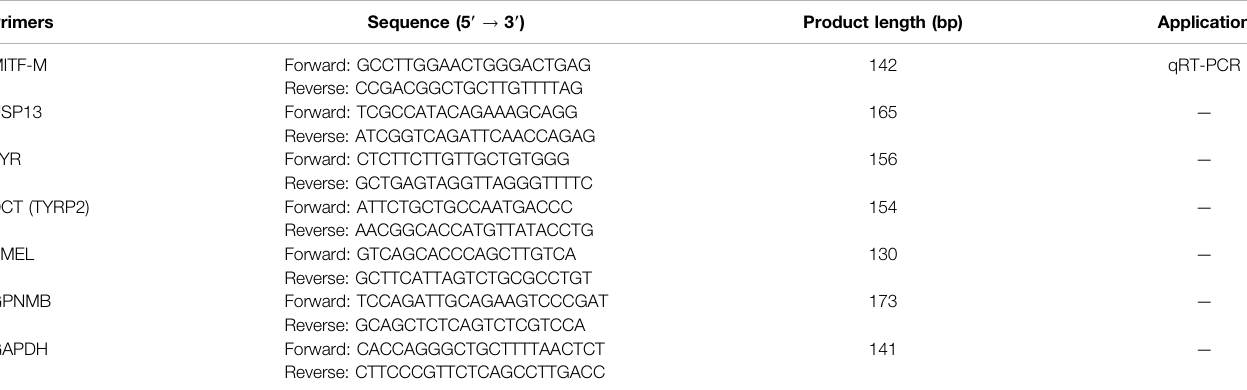
TABLE 3 | qRT-PCR primer